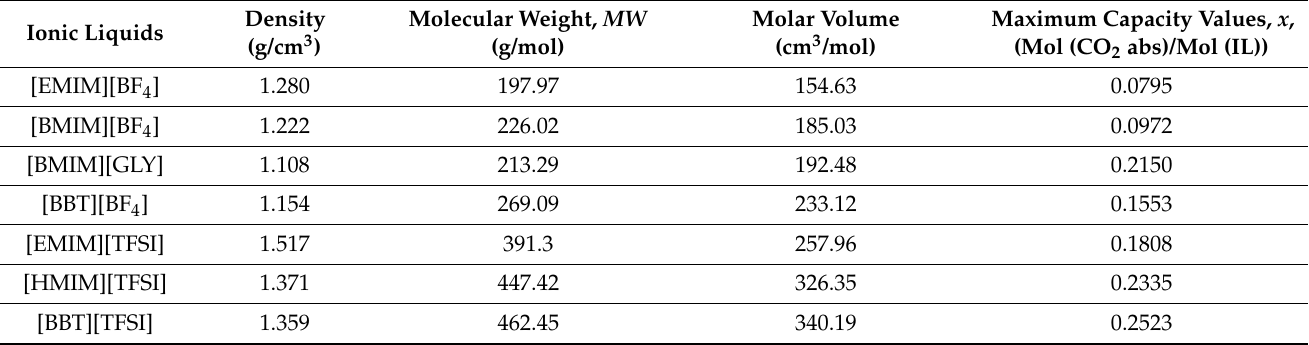
Table 1. The density at 25 ◦ C, the molar volume, and the maximum capacity values for different